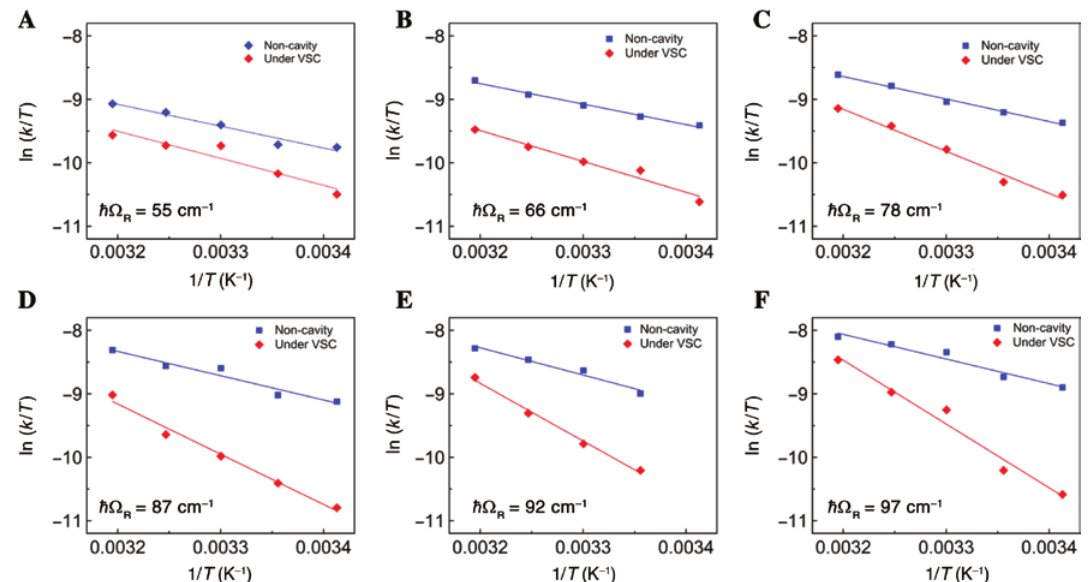
Figure 2: Eyring plots of reaction under VSC and noncavity conditions. (A–F) Plots of reaction rate as a function of temperature under VSC (red diamonds) for the various Rabi splitting energies and the corresponding plot for noncavity reactions (blue squares). The different values of ħ Ω used to fit the data, and the goodness of the fit was assessed based on the coefficient of determination ( R 2 ) value. For each fit, R 2 value was ≥